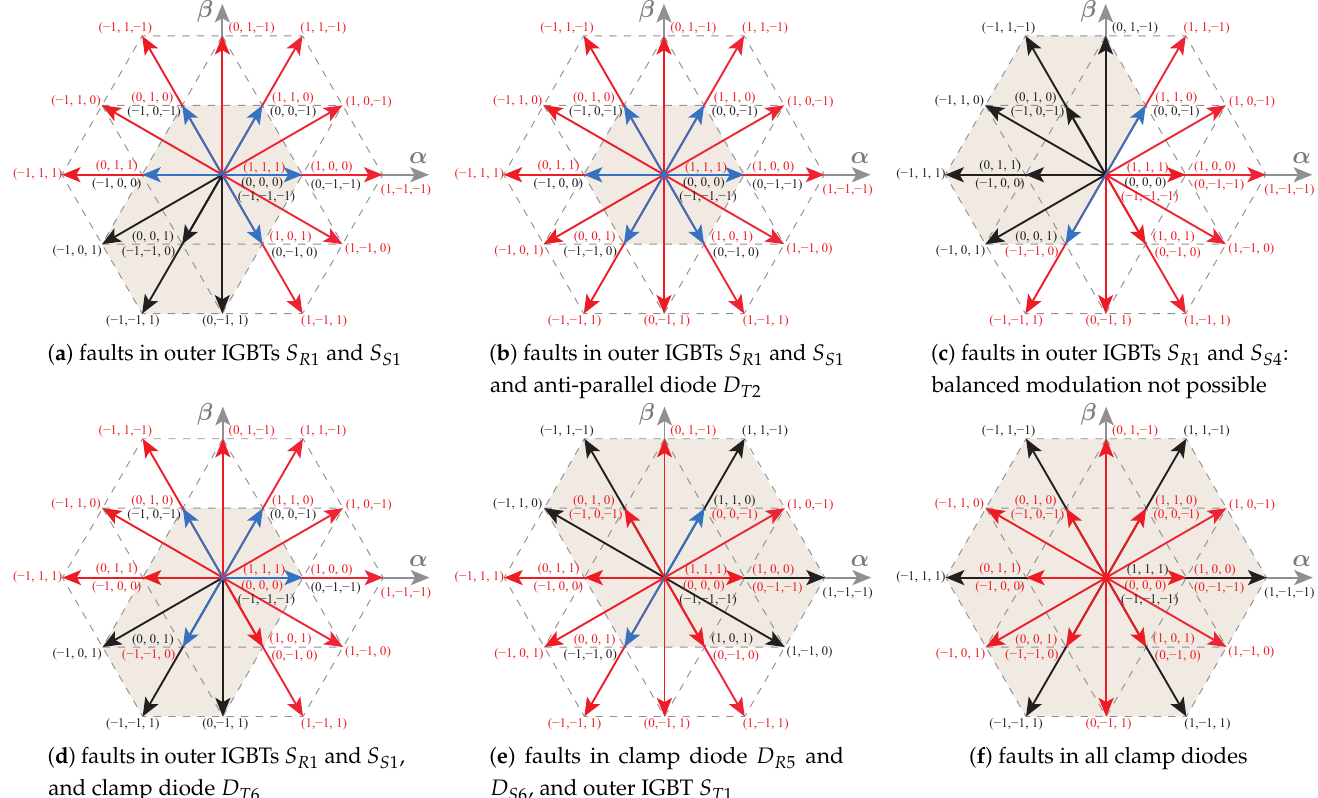
Figure 3. Available voltage vectors and modulation area with multiple OC faults (available modulation area in gray; vectors in red are unavailable and those in blue have lost